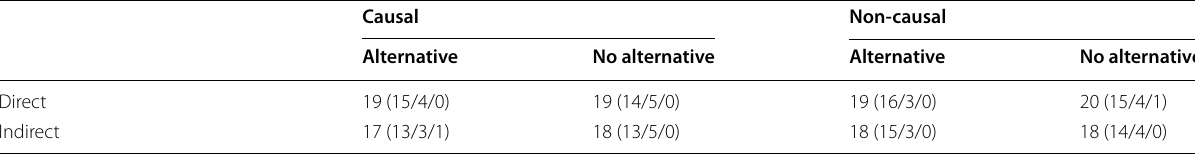
24 (24/0/0) individuals participated in the No (mis)information baseline and 18 (14/4/0) individuals participated in the No correction baseline